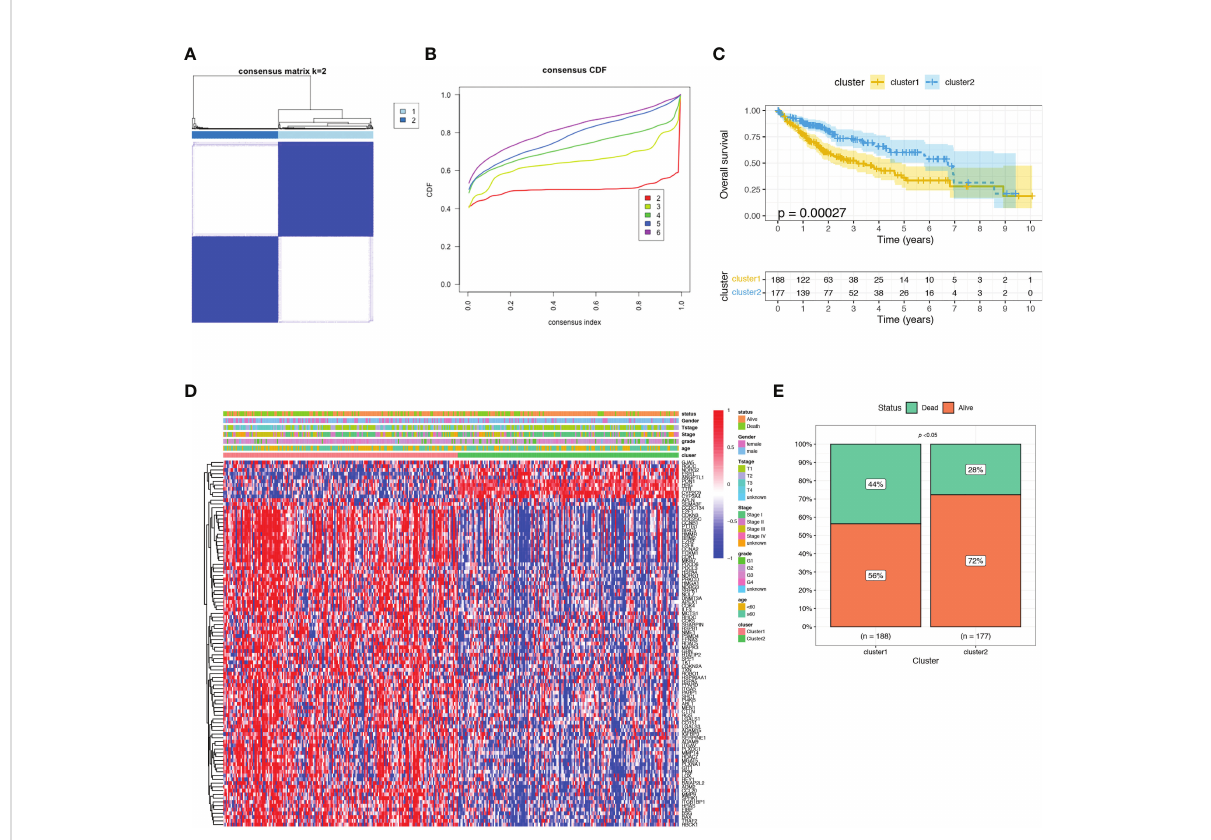
FIGURE 3 Consensus clustering analysis of identi fi ed prognostic ARGs in TCGA dataset. (A) Consensus matrix heatmap de fi ning two clusters (k = 2). (B) Consensus clustering cumulative distribution function (CDF) with k valued 2 to 9 in TCGA dataset. (C) KM curve for the two clusters. (D) Differences in clinical characteristics and ARGs expressions between the two distinct clusters. (E) The surviving fraction compared between Cluster 1 and Cluster